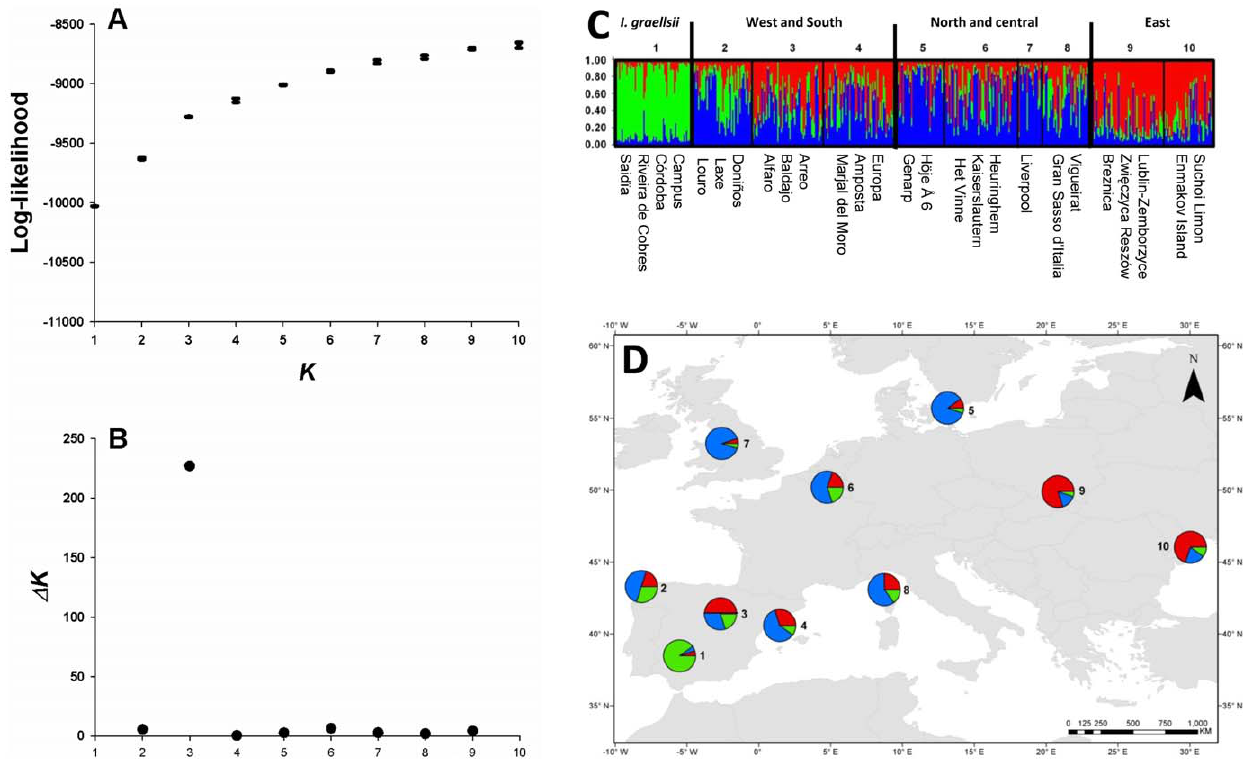
Figure 3. Estimated population structure of the 22 I.elegans populations and the four I.graellsii populations from Bayesian structure analysis using the program STRUCTURE 2.2.3. A ). Mean likelihood ( 6 SD) of K for different numbers of clusters B ) D K -values for different K ; suggesting K =3 as the most likely structure according to Evanno et al. [41]. C ) Individual Bayesian assignment probabilities for K =3 for 22 populations of I. elegans and the outgroup I. graellsii (grouped for visualisation into ten geographically close groups). Individuals are represented by thin vertical lines, which are partitioned into K shaded segments representing each individual’s estimated membership fraction. D ) Pie charts show the mean membership fractions to each of the three genetic clusters in ten groups of